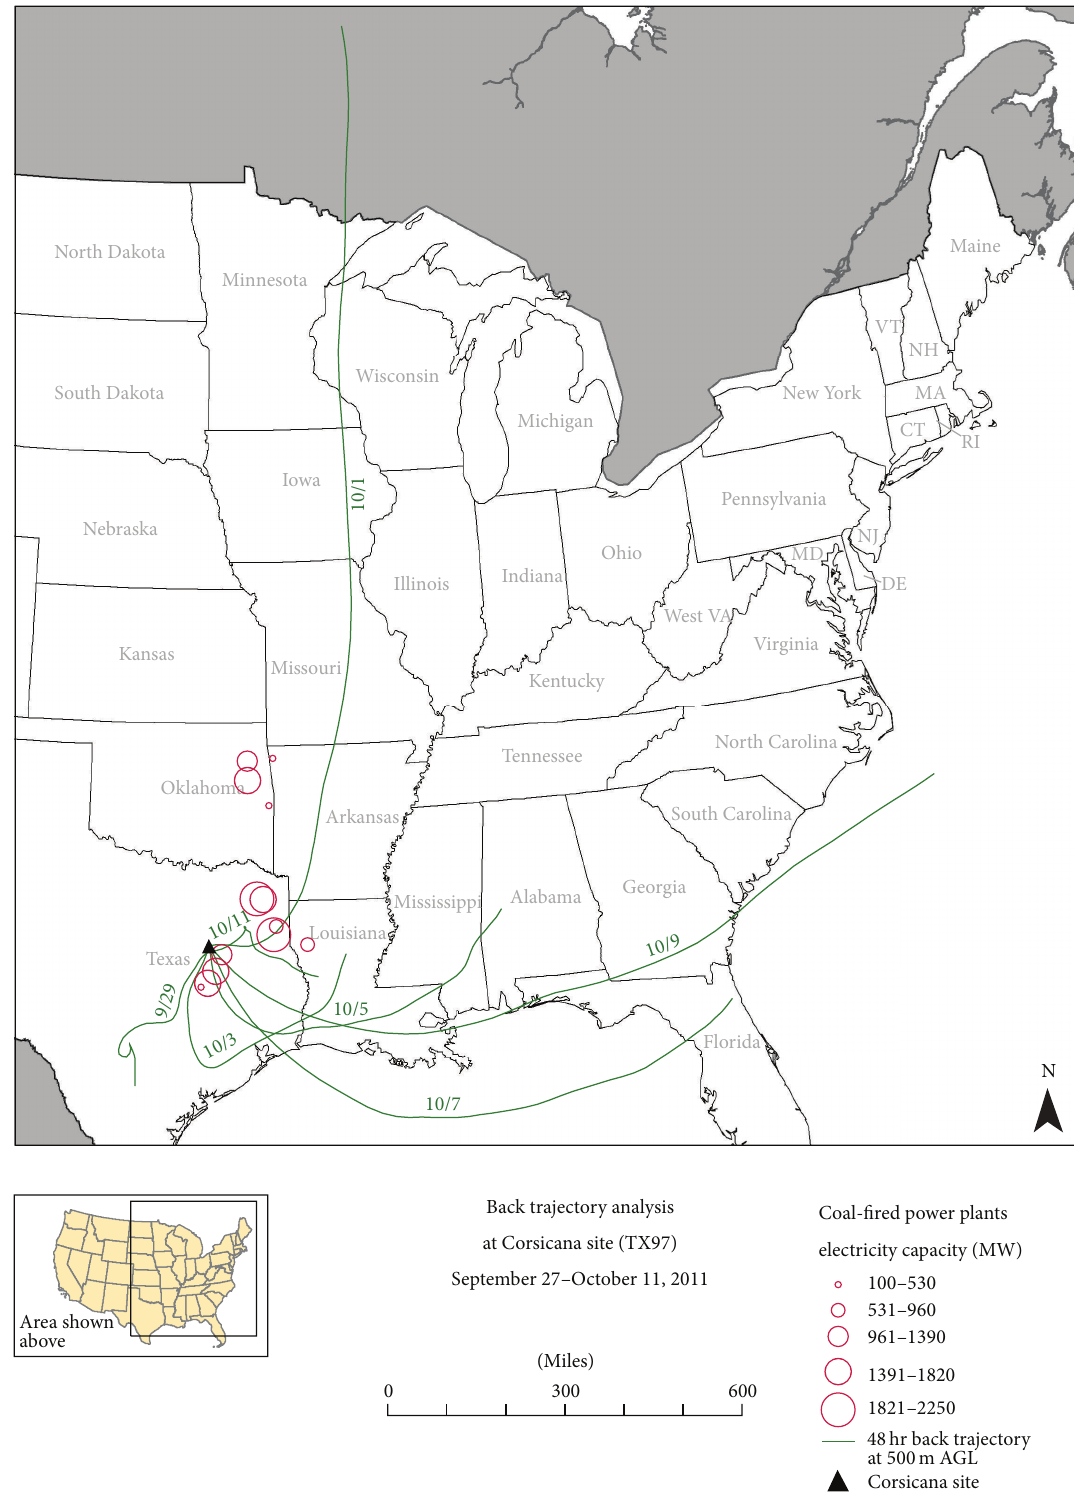
Figure 3: Back trajectory analysis for the Corsicana site (TX97) for September 27 to October 11, 2011. Seven contiguous 48-hour back trajectories ending at 1100 LST on October 11, 2011. End date of each 48-hour back trajectory plotted for each trajectory trace (e.g., 9/29 represents 48-hour back trajectory for 9/27–9/29). Coal-fired power plant locations are located at center of open